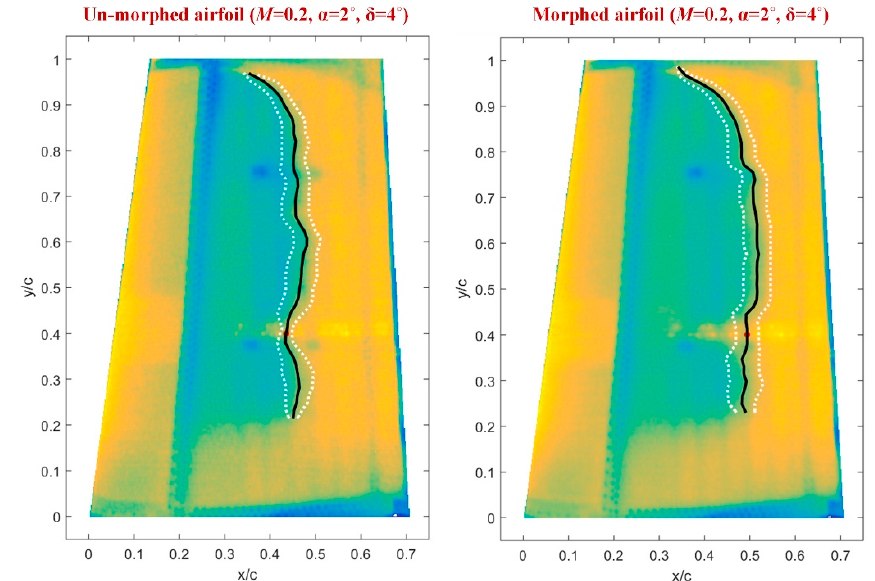
Figure 21. The infrared thermography results for M = 0.2, α = 2 ◦ , and δ = 4 ◦ flow conditions.